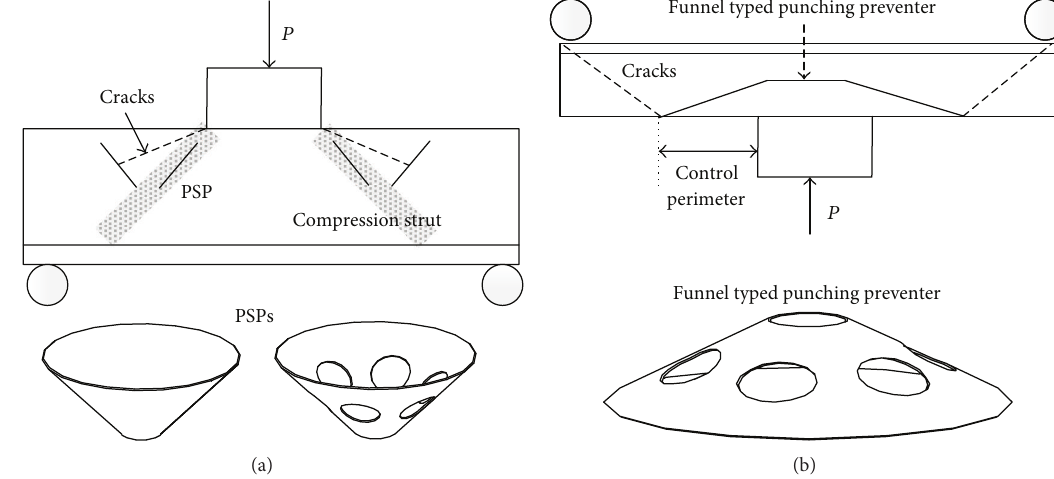
Figure 1: Schematic view of (a) footing with PSPs and (b) flat slab with funnel typed punching shear